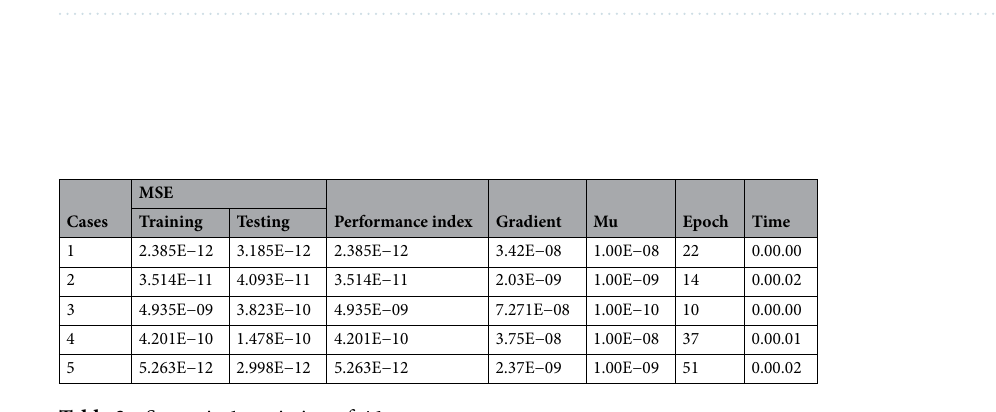
Table 3. Scenario 1: variation of A 1